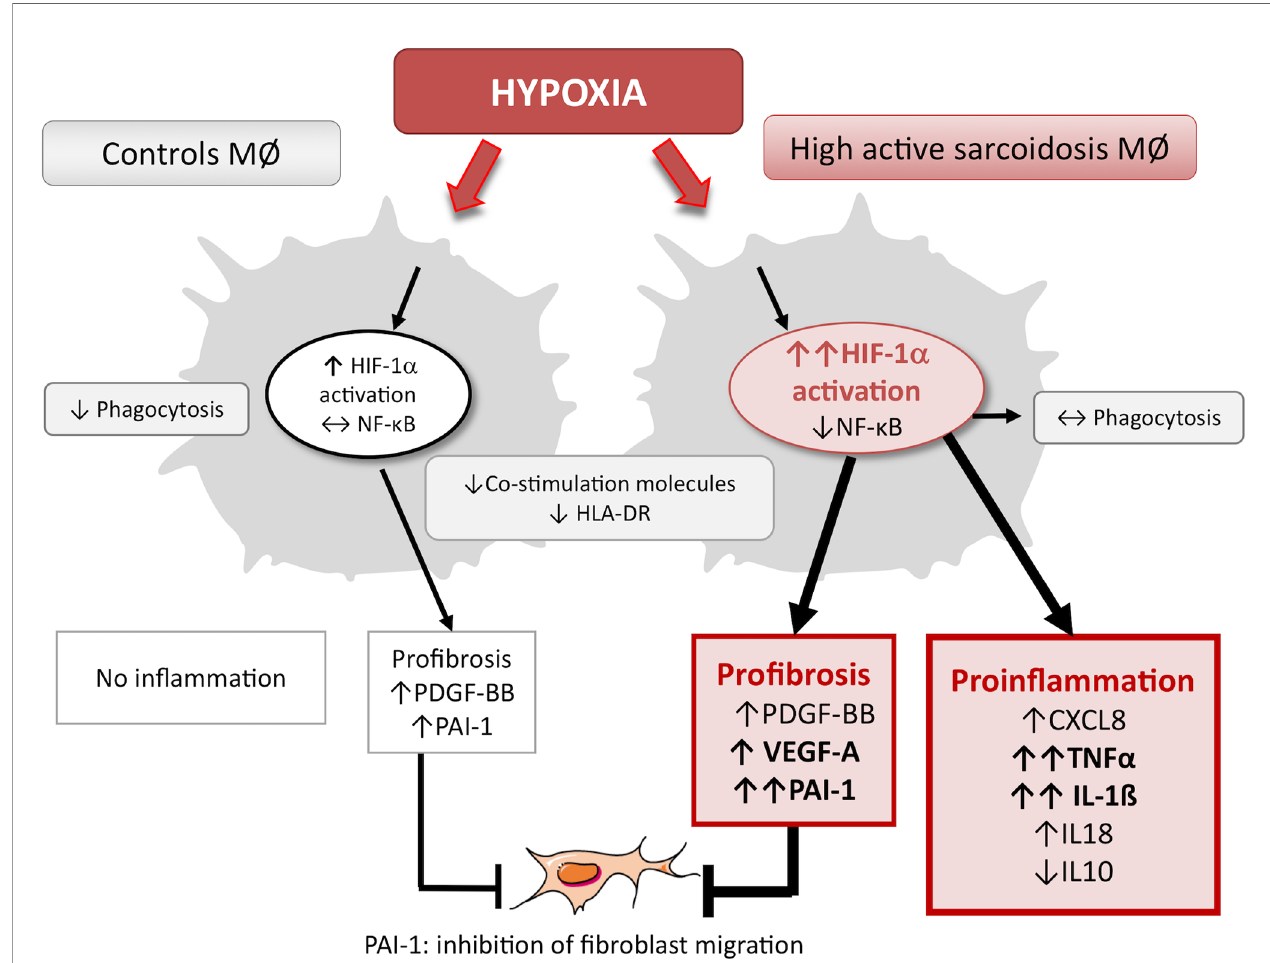
FIGURE 8 | Summary of hypoxia biological impact on MD-macrophages from controls versus high active sarcoidosis. Hypoxia induced in MD-macrophages a signi fi cantly more pronounced effect in high active sarcoidosis compared with controls. It increased the HIF-1 a trans-activity, promoted a proin fl ammatory response without activating NF- k B pathway and a pro fi brotic response (TGFß1, PDGF-BB) with PAI-1 secretion associated with human lung fi broblast migration inhibition. Hypoxia also decreased the expression of CD80/CD86 and HLA-DR on MD-macrophages in the two groups while it did not impair phagocytosis and the surface expression of CD36 on cells from high active sarcoidosis at variance with controls. MØ,